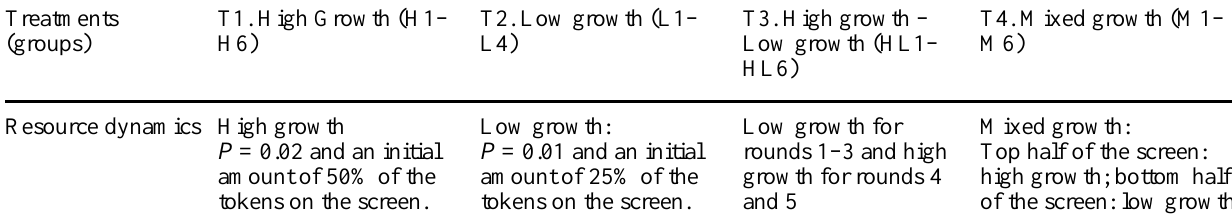
Low growth for Mixed growth: rounds 1–3 and high Top half of the screen: growth for rounds 4 high growth; bottom half and 5 of the screen: low